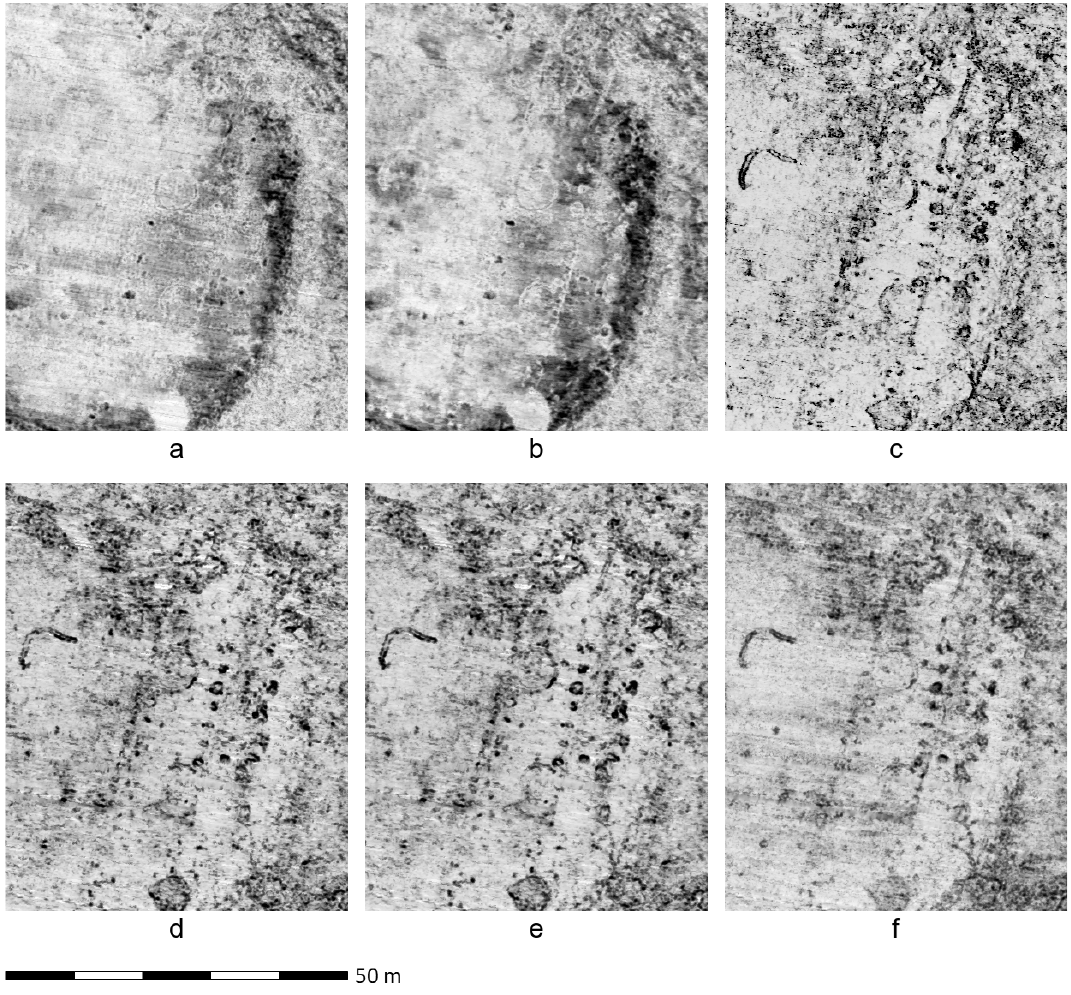
Figure 9. Depth range 40–45cm. ( a ) Unmigrated amplitude values. ( b ) Migrated amplitude values. ( c ) Inline coherence migrated. ( d ) Crossline coherence migrated. ( e ) In+crossline coherence migrated. ( f ) In+crossline coherence